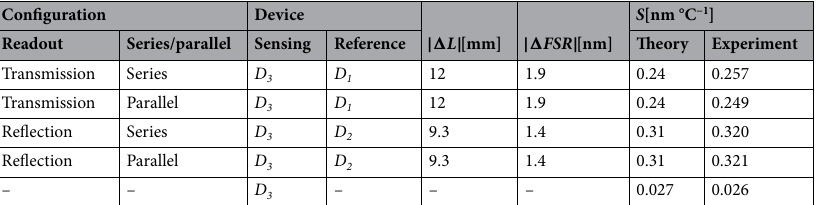
Table 1. Summary of studied configurations and experimental results. The table includes the difference in length of the SCF used for the sensing and reference devices ( Free Spectral Range